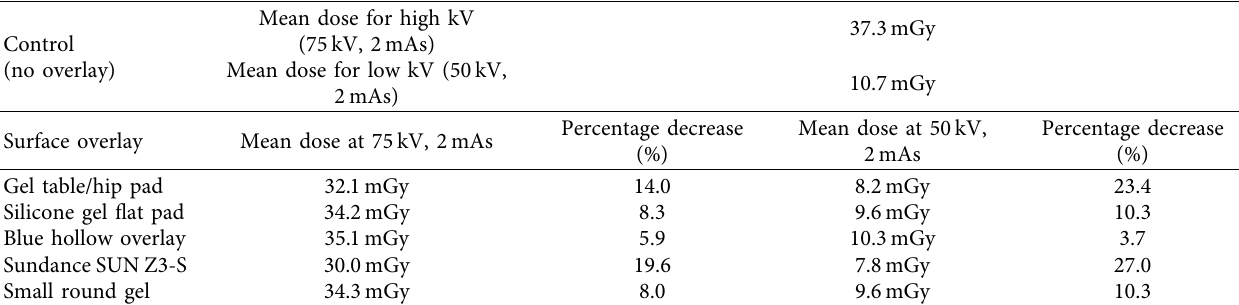
Table 2: Mean recorded dose at low and high tube potentials with corresponding percentage